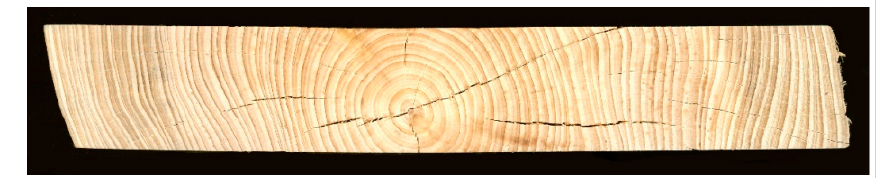
Figure 3. Transverse section of oriental arborvitae across the entire diameter of the tree trunk.